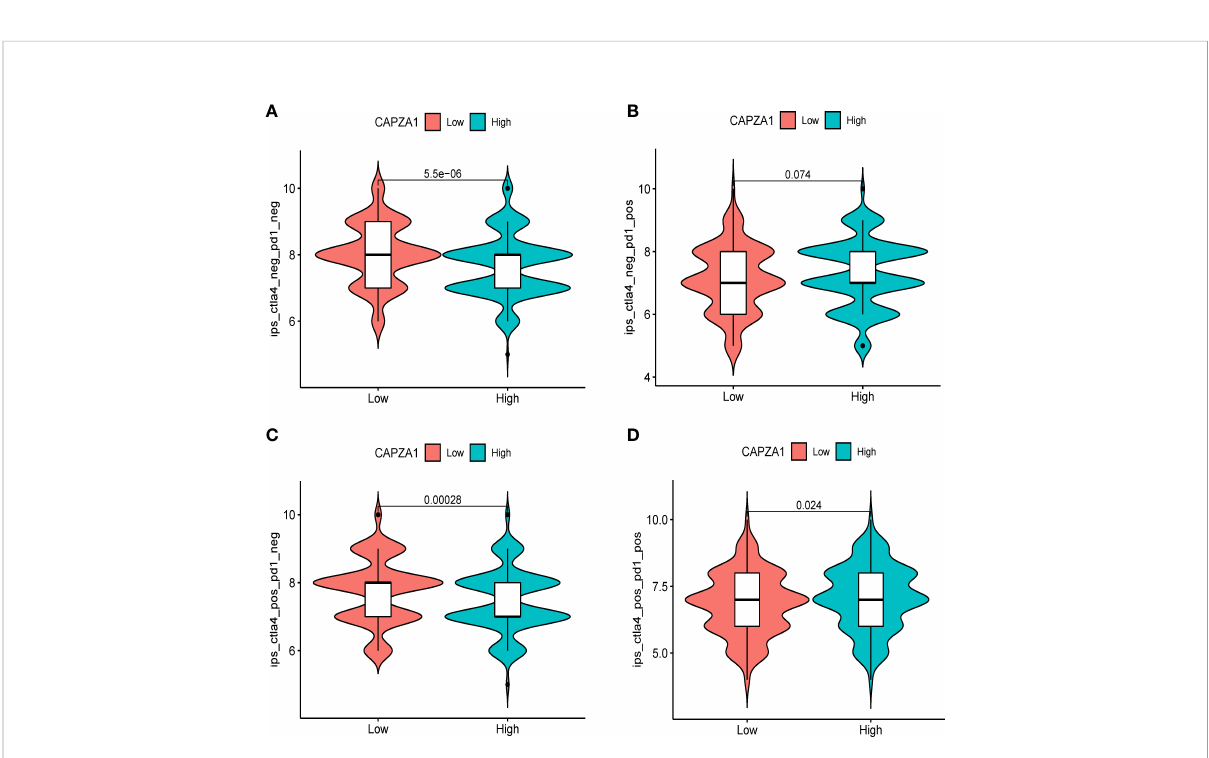
FIGURE 9 Correlation of CAPZA1 expression with the immunophenoscore (IPS) in HCC. (A) ips_ctla4_neg_pd1_neg, (B) ips_ctla4_neg_pd1_pos, (C) ips_ctla4_pos_pd1_neg, and (D)